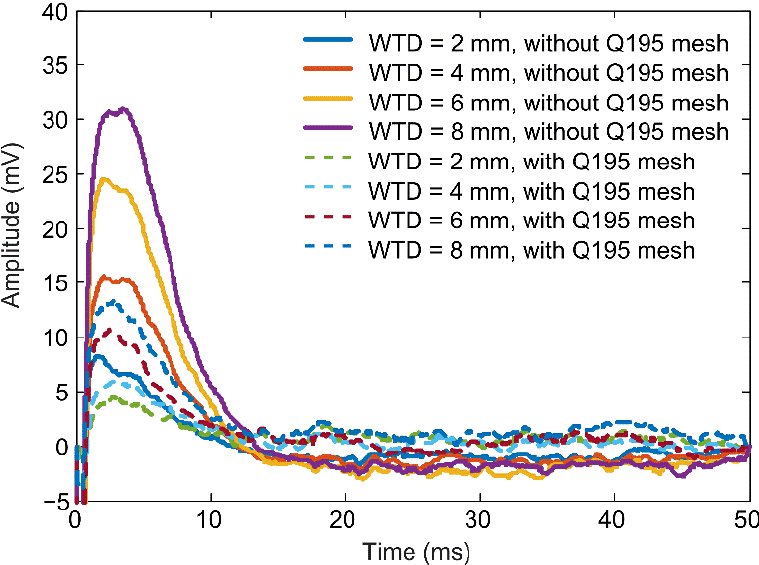
Figure 13. Experimental differential signals acquired from 2 mm, 4 mm, 6 mm, and 8 mm deep wall-thinning zones, without and with the covering of a Q195 mesh, respectively.